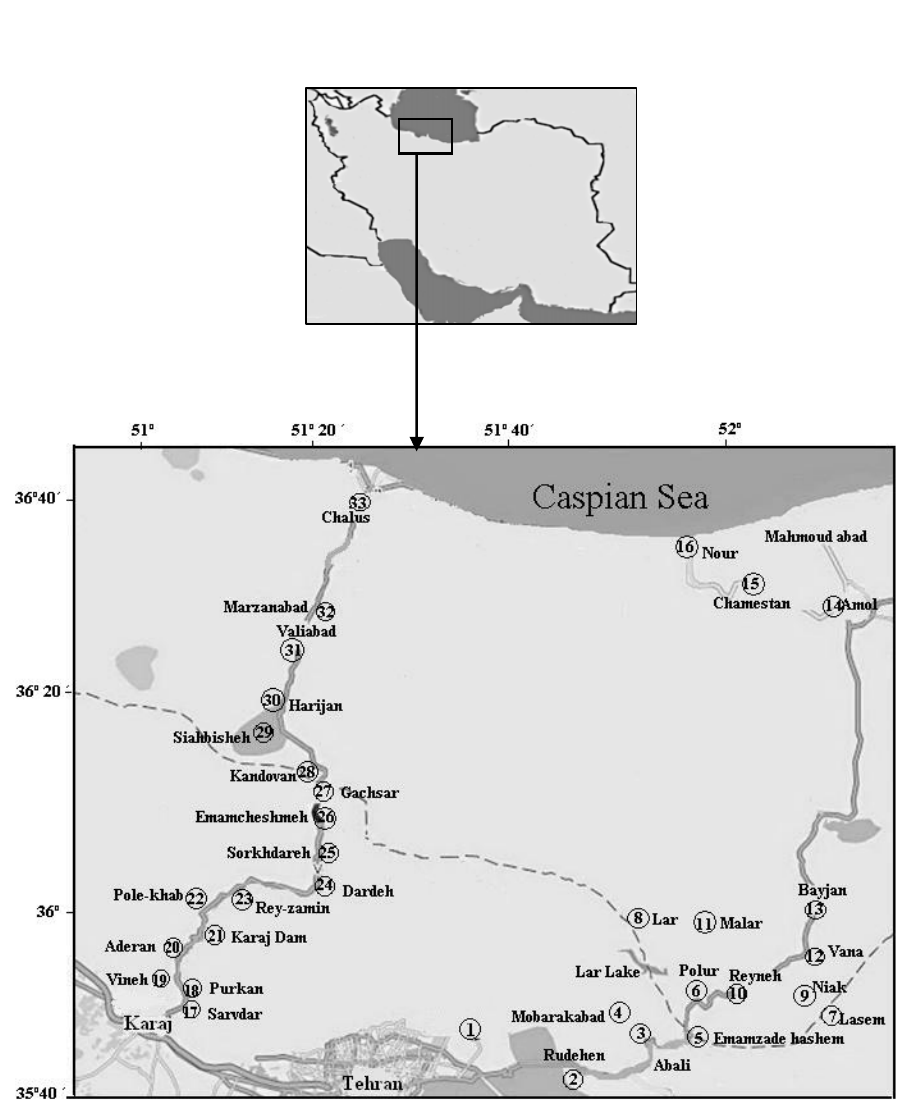
Twelve lumbricid species belonging to seven genera were identified: Aporrectodea caliginosa , A. rosea, A. jassyensis, Dendrobaena byblica complex , D. octaedra, D. hortensis, D. veneta, Dendrodrilus rubidus, Eisenia fetida, Eiseniella tetraedra, and Octolasion lacteum, Perelia kaznakovi. Species richness was not equally distributed among the genera. The four species of Dendrobaena were the most for any genus.